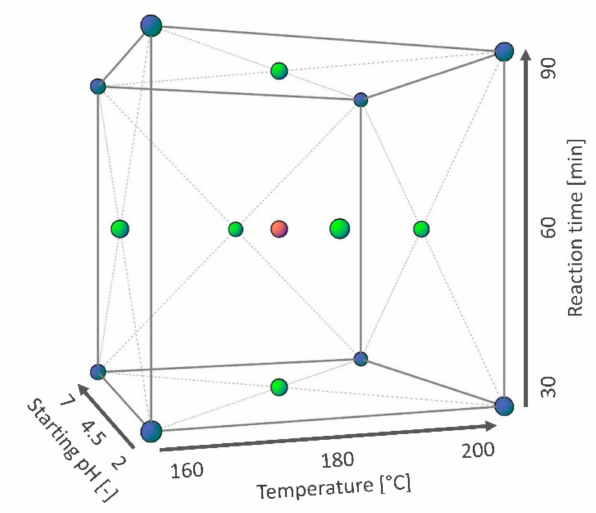
Figure 1. Design space of the face-centered central composite design (FCCD), red dots indicate triplicates, green dots duplicates, and blue dots single